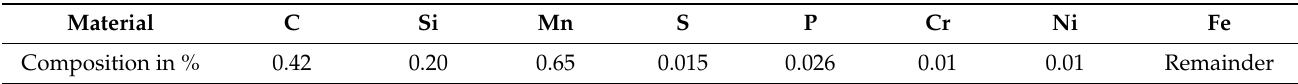
Table 2. Chemical composition of substrate EN8.